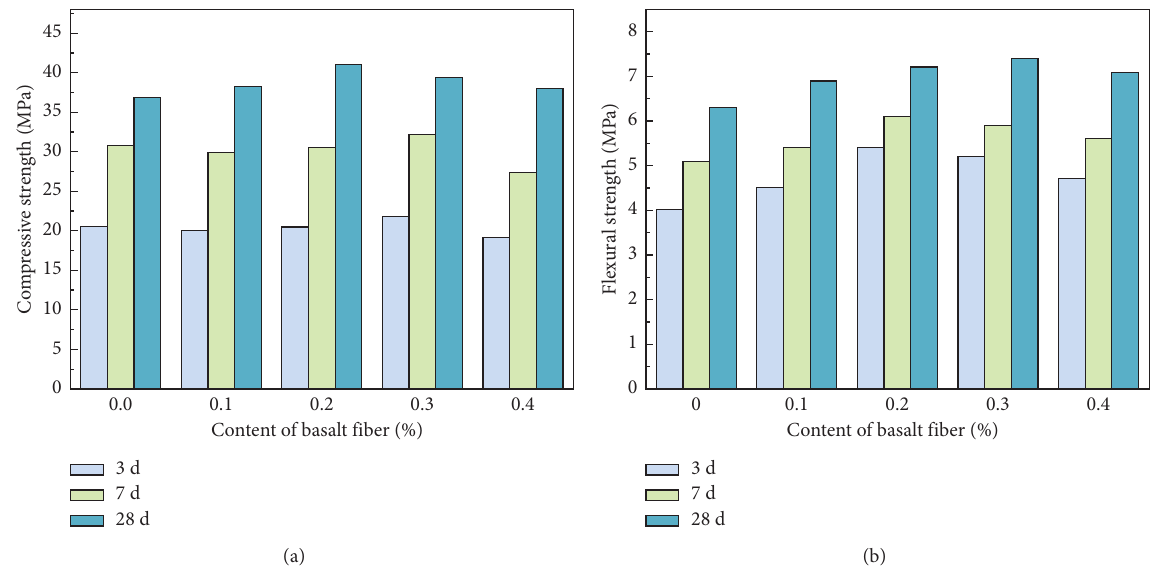
Figure 2: Strength of geopolymers mixed with different basalt fibre contents. (a) Compressive strength and (b) flexural strength.